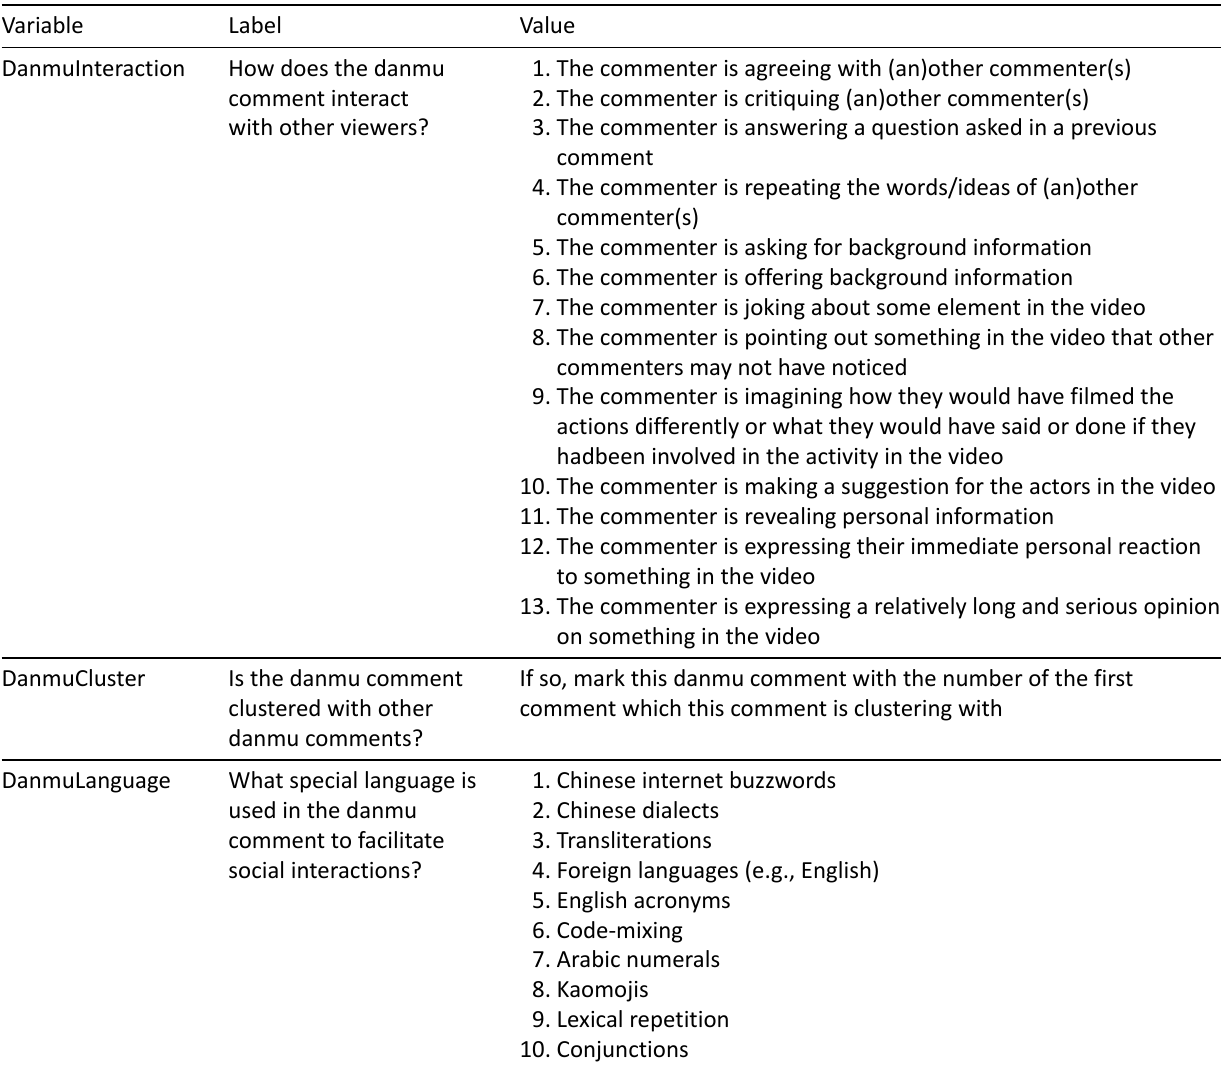
Table 1. Coding scheme categorising social interactions among danmu comments.